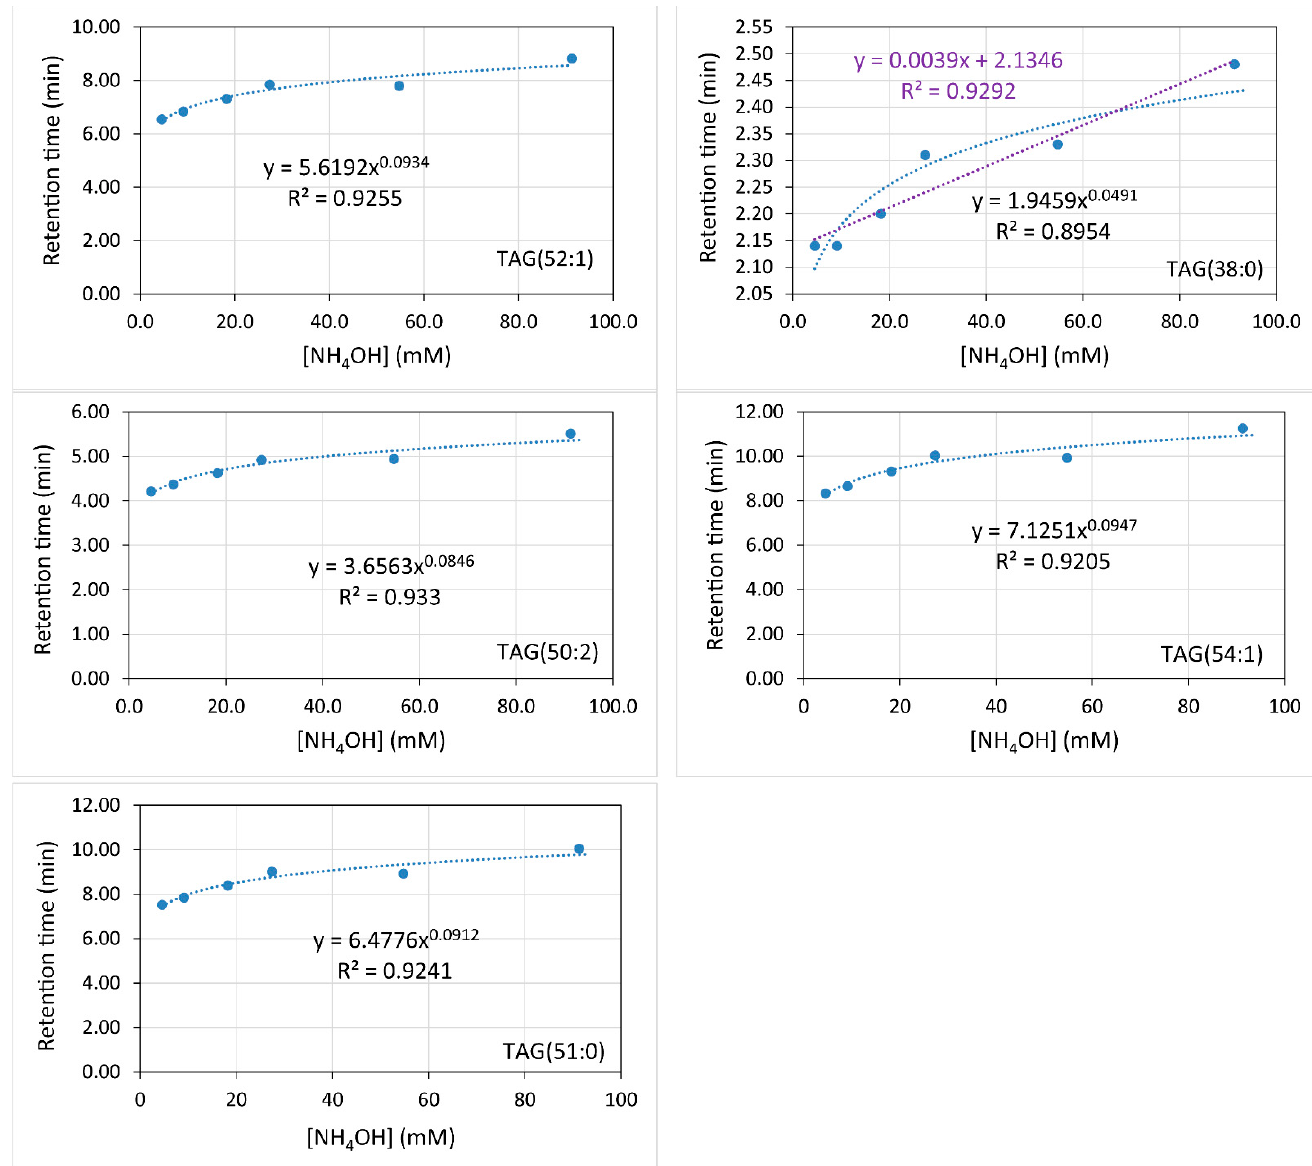
Figure 2. Variation of elution time with NH 4 OH concentration for diverse triacylglycerol standards.